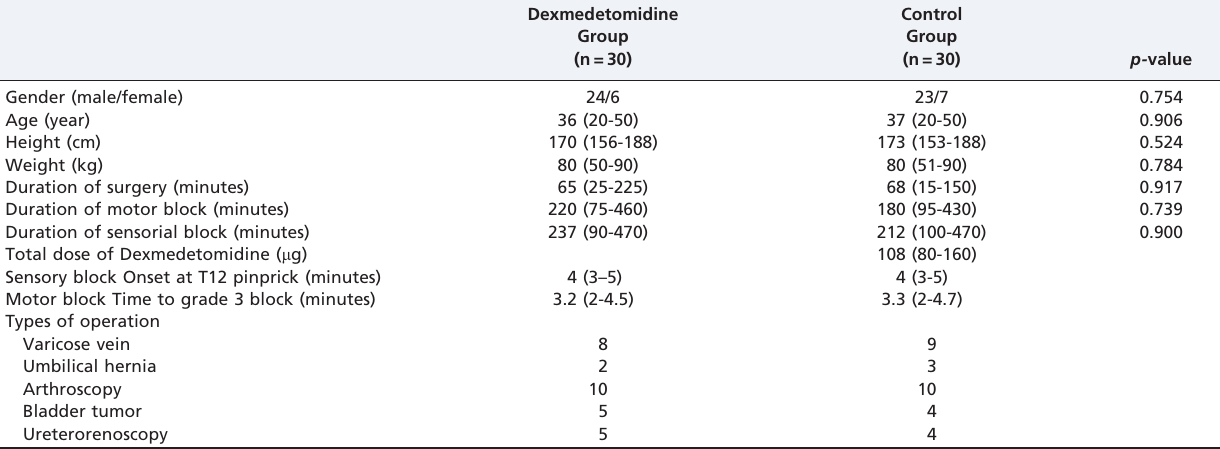
Table 1 - Demographic and intraoperative variables of the subjects - medians and